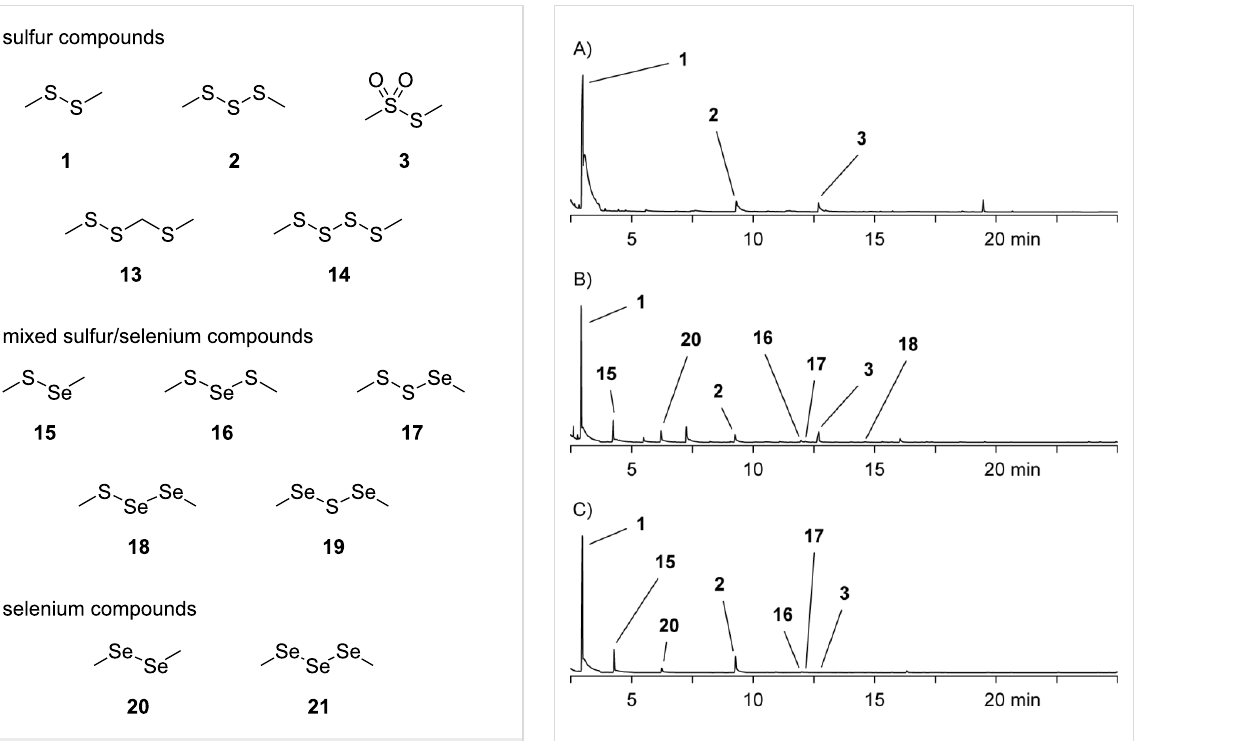
Figure 7: Chromatograms of headspace extracts from P. gallaeciensis grown on (A) 50% MB2216, (B) 50% MB2216 + 1 mmol/l Na 2 SeO 4 , (C) 50% MB2216 + 1 mmol/l Na 2 SeO 3 . File 1, Figure S2). The production of methylated selenium volatiles from the selenate and selenite salts was especially pronounced for H. phototrophica from the order rhizobiales, a close relative of Roseobacter clade bacteria. In addition, the sulfur volatiles bis(methylthio)methane ( 22 ), S -methyl propanethioate ( 23 ), 4-(methylthio)butan-2-one ( 24 ), S -methyl 3-(methylthio)propanethioate ( 25 ), and benzothiazole ( 26 ) were found in strain-specific patterns (Figure 8). Cyclic sulfur volatiles, such as 1,2,4-trithiolane ( 27 ), 1,2,4,5-tetrathiane ( 28 ), and lenthionine ( 29 ), compounds that are known from Shiitake mushrooms ( Lentinus edodes ) [28-30], were solely produced by R. denitrificans